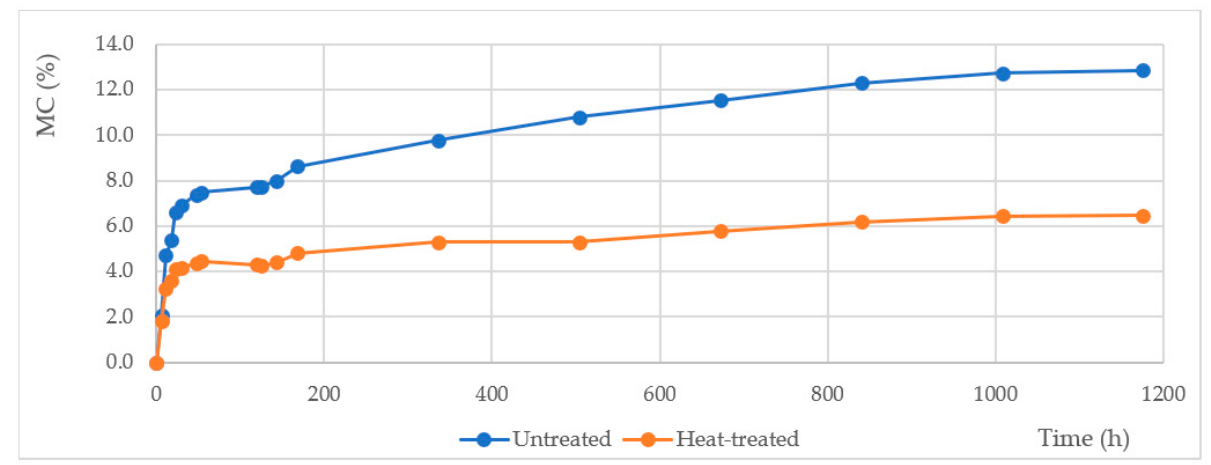
Figure 2. Temporal increase in moisture content of untreated and heat ‐ treated ayous wood. The weight increment was monitored after the complete drying of the samples using a ventilated oven (103 ± 2 °C for 24 + 6 h). After 504 h, the samples were put in a conditioning chamber with 70% RH. Table 2. Wood moisture content difference between untreated and heat ‐ treated over time and related reduction percentage.